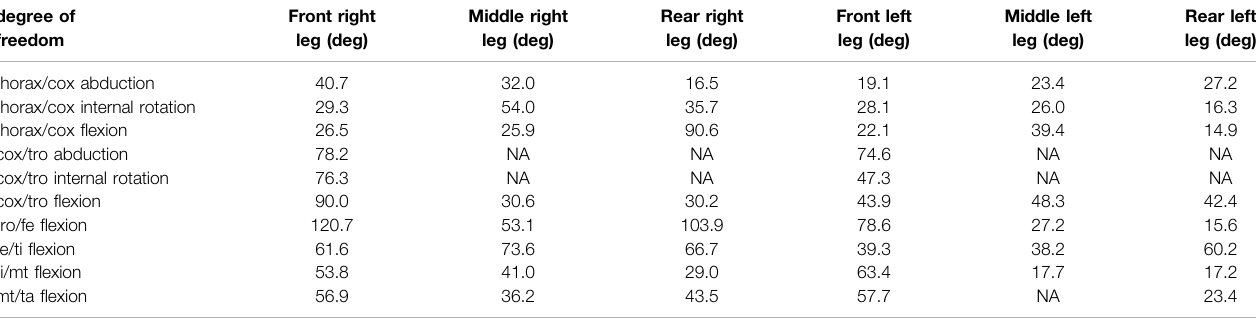
TABLE 5 | Results of the sensitivity analysis. These results represent the average signal-to-noise ratio per joint obtained from marker perturbation ( fi rst column) and axis perturbation (second column). In the case of cox/tro, tro/fe, fe/ti, ti/mt, and mt/ta joints, averages were calculated from the signal-to-noise ratio of the six legs. Joint Signal-to-noise ratio from marker perturbation Signal-to-noise ratio from axis perturbation all